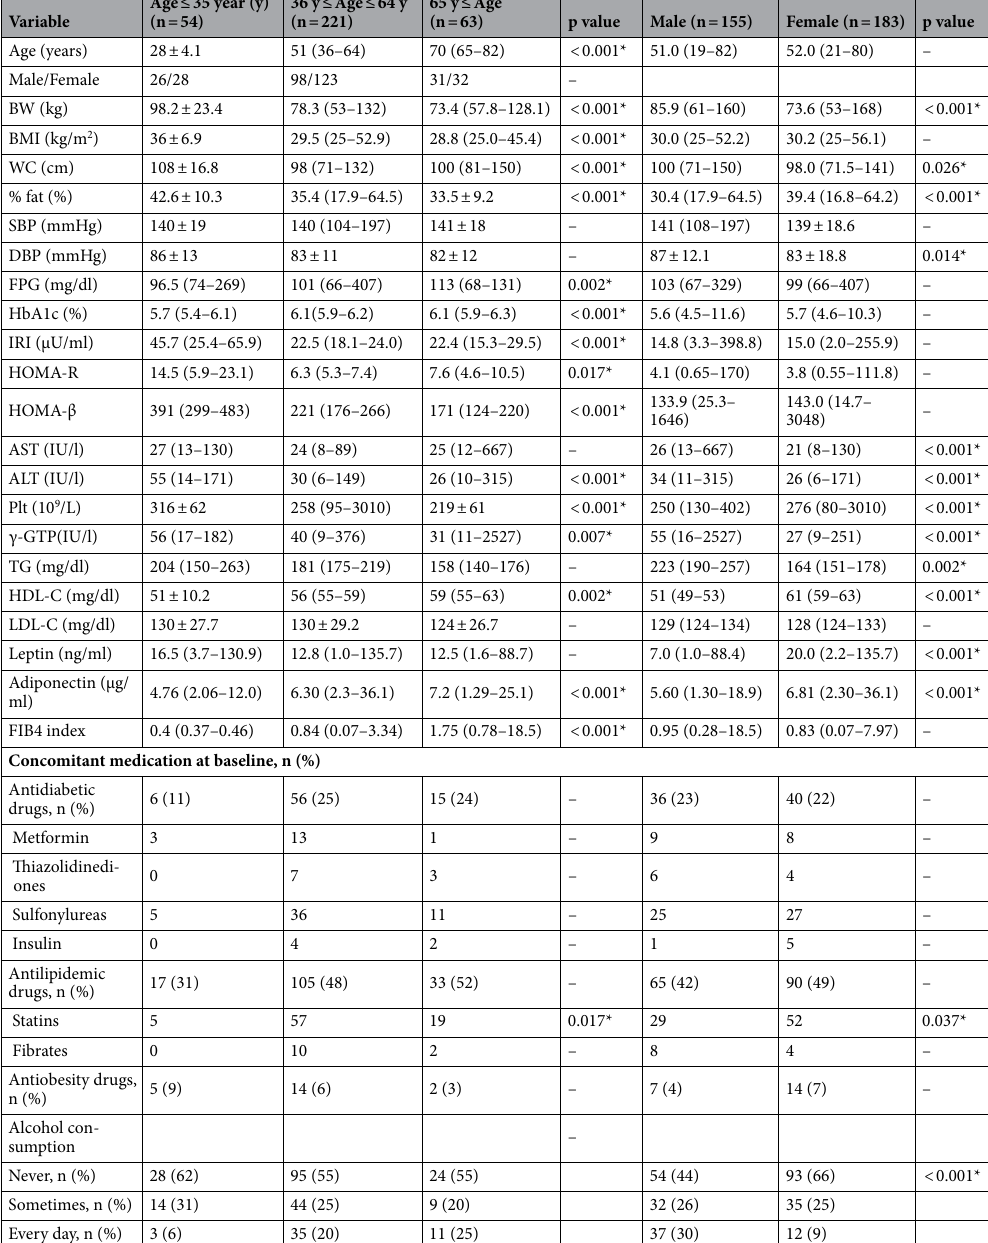
Table 2. Baseline characteristics of patients categorized by age and sex. Data are expressed as the mean ± SD, medians (min, max), or percentages. Asterisks indicate a significant difference (p <